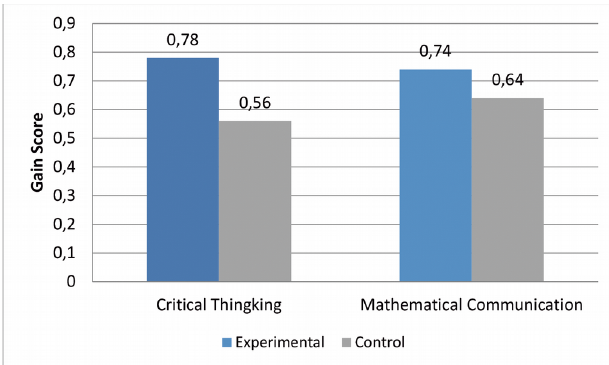
Figure 4. N-Gain Differences between Experimental and Control Classes